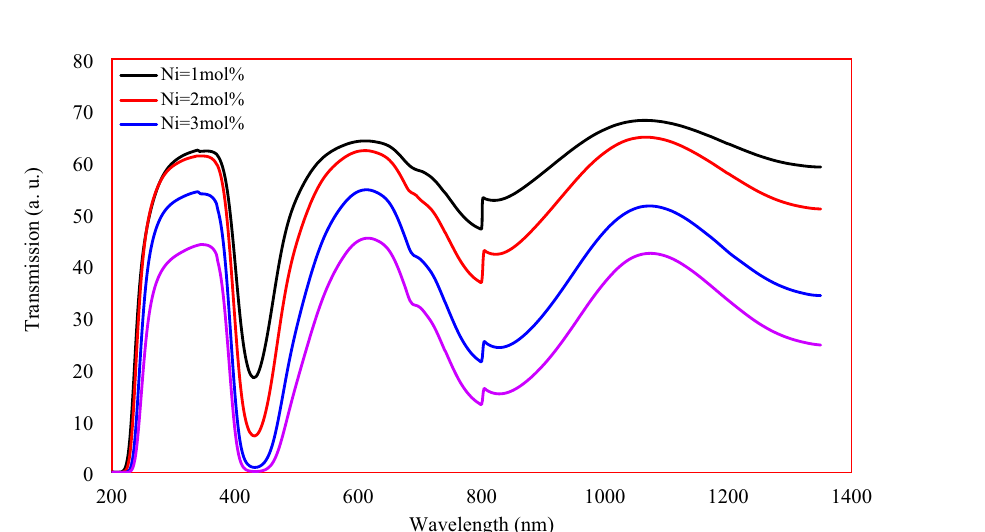
Figure 12. Phonon absorption and emission of Ni doped glasses to calculate optical band gap.